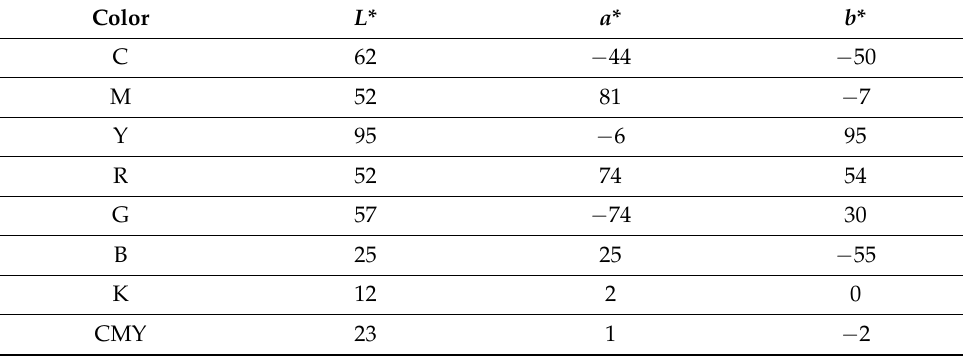
Table 2. Digital reference values of CMYKRGB colors L * a * b